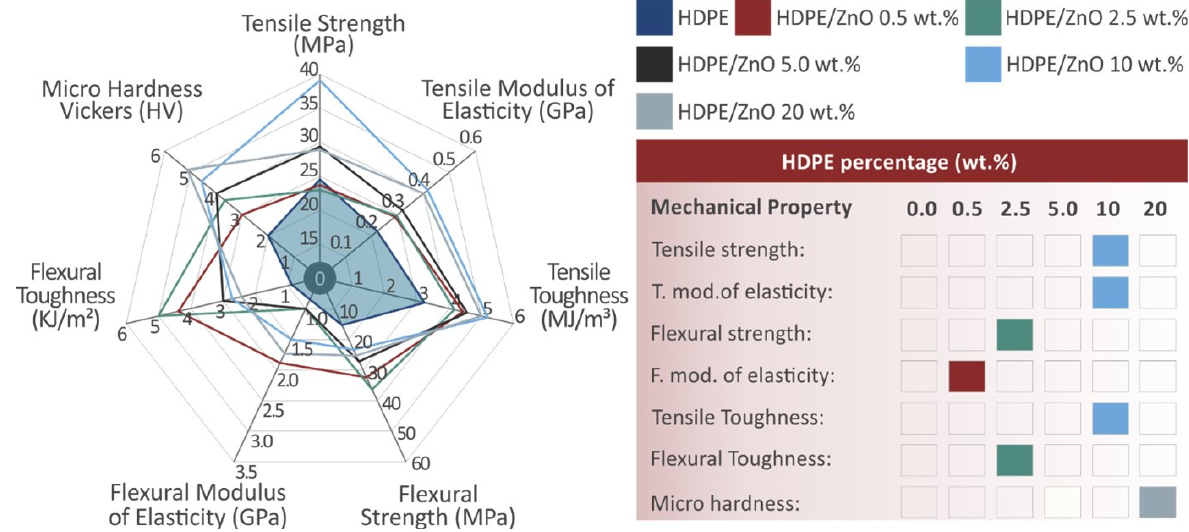
Figure 11. Overall mechanical properties.